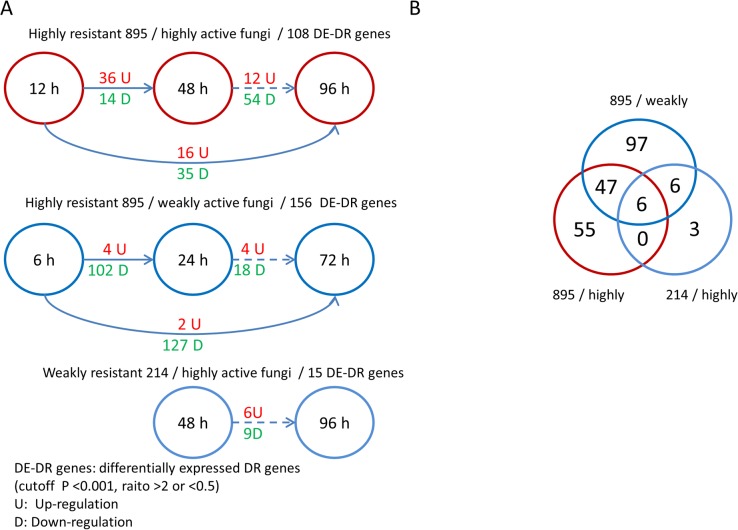
More poplar DR genes were up-regulated in the highly resistant 895/highly active fungus group during infection (especially during the early stage).(A) The differentially expressed poplar disease-resistant genes between different time points in three groups. (B) The overlapping DE-DR genes among the three groups.